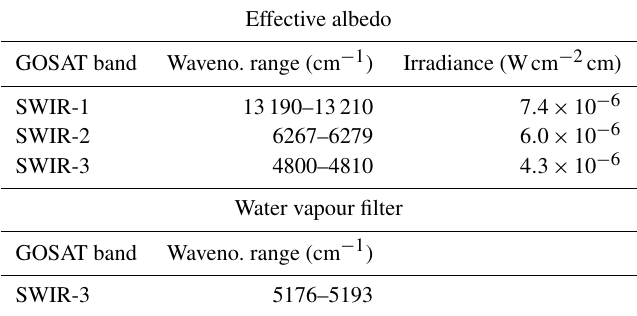
Table 3. Parameters for cloud filtering.